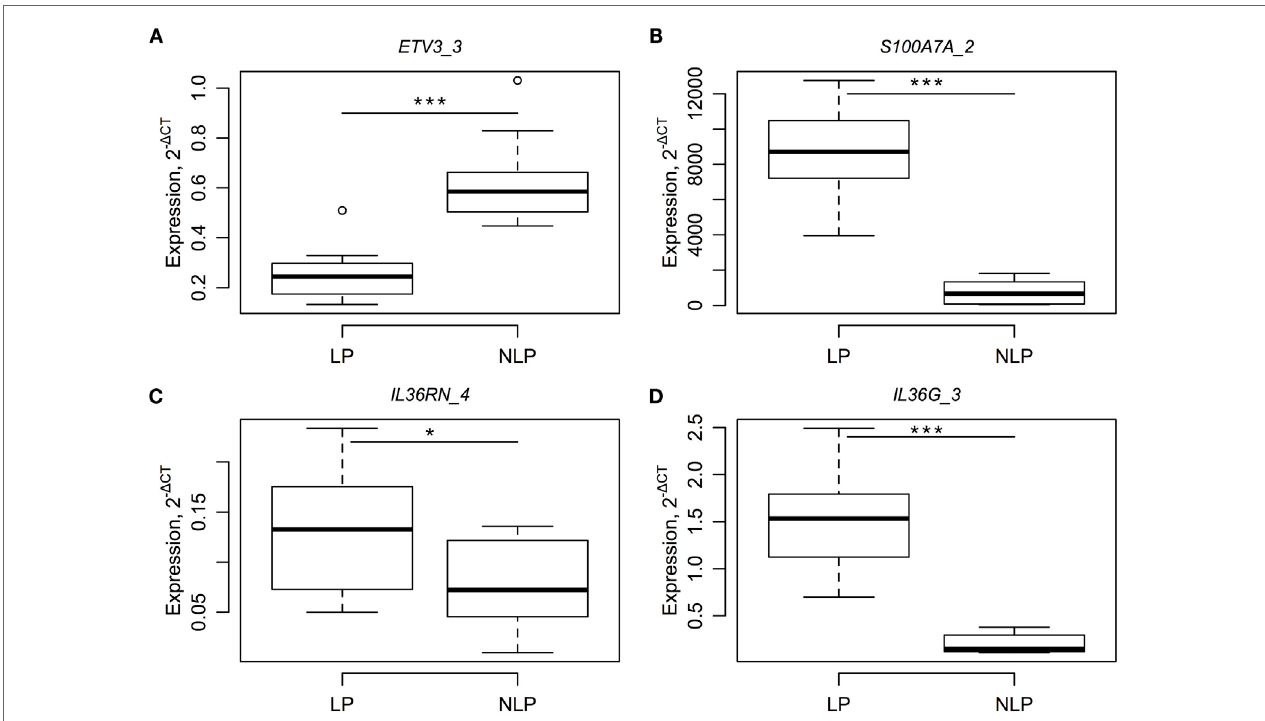
FigUre 3 | rT-Pcr results for four different rna isoforms (a–D) and a comparison between paired lP and nlP samples . RNA levels of individual genes ( a–D are ETV3_3, S100A7A_2, IL36RN_4 and IL36G_3) are expressed relative level to the housekeeper gene. Statistical significance for the paired t -tests is designated as *, a p -value less than 0.05 and ***, a p -value less than